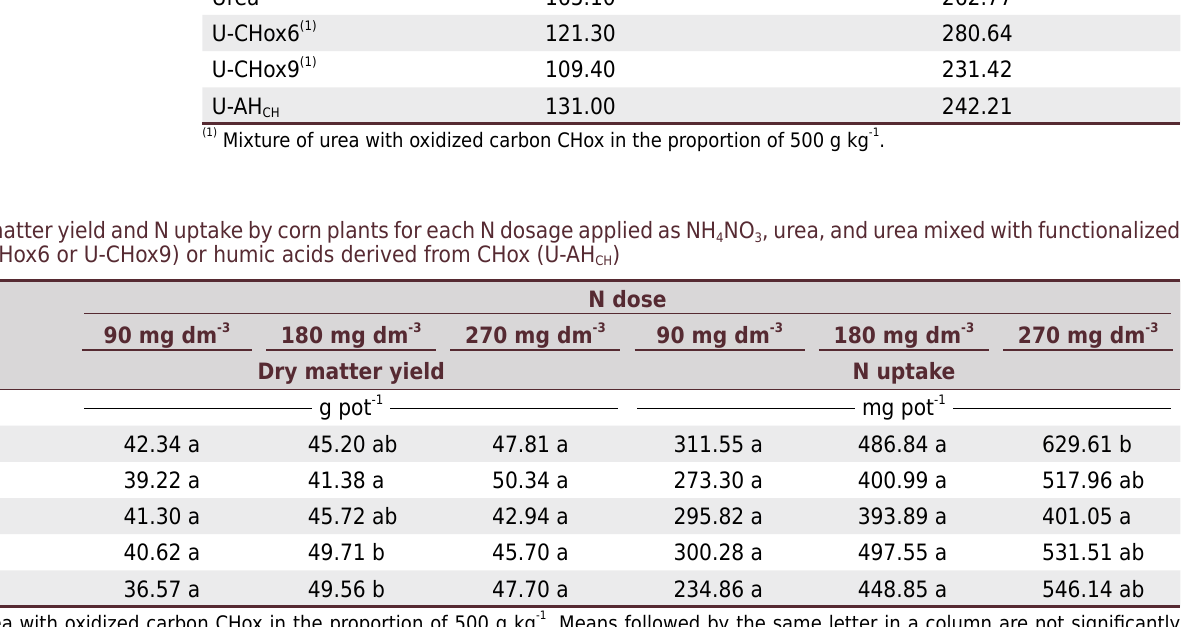
Mixture of urea with oxidized carbon CHox in the proportion of 500 g kg -1 . Means followed by the same letter in a column are not significantly different according to Tukey’s test (p=0.05).